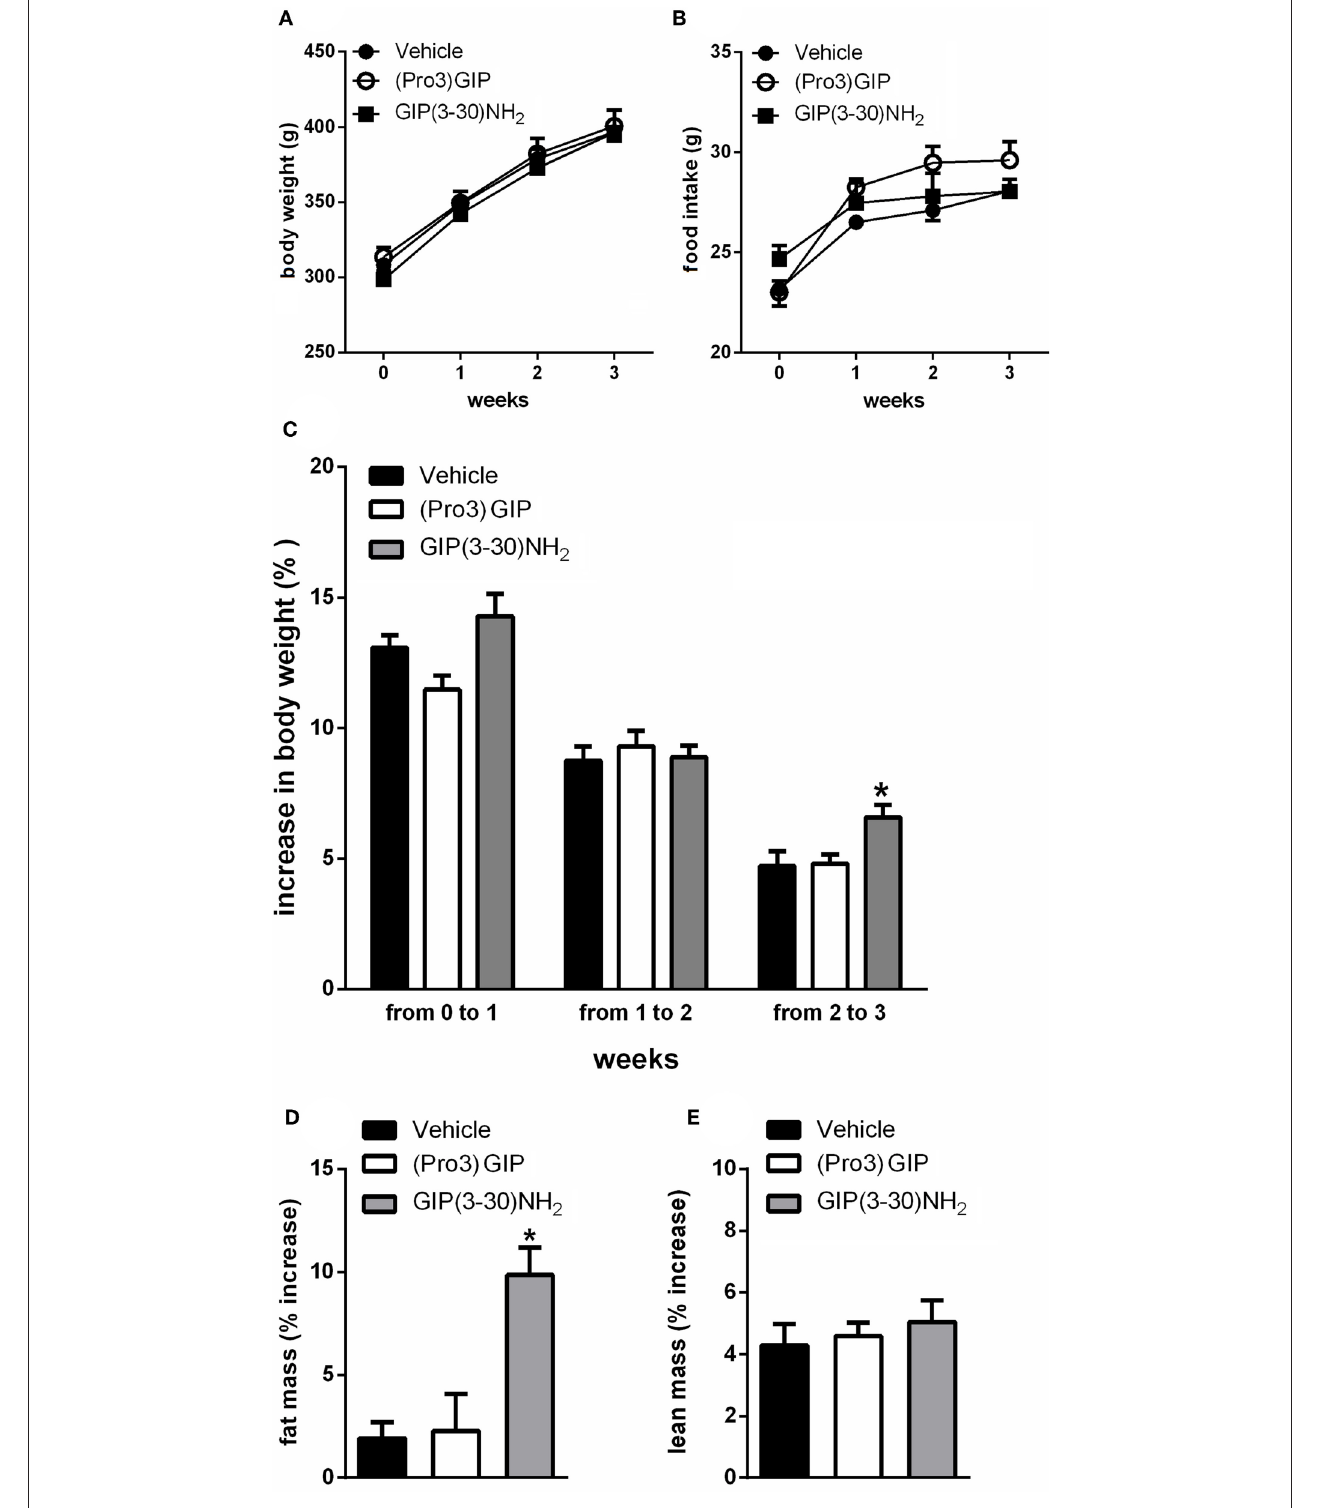
FIGURE 1 | Effects of the subchronic treatment with GIP (3–30)NH 2 (25 nmol/kg b.w.), (Pro3)GIP (25 nmol/kg b.w.) or vehicle treated on food intake, body weight, total body composition: Body weight (A) , Food intake (B) , Body weight gain (C) , Changes in total fat (D) , and lean (E) mass, measured by NMR. Data are mean values ± S.E.M. ( n = 6 rats/group). * p < 0.05 vs. vehicle treatment.